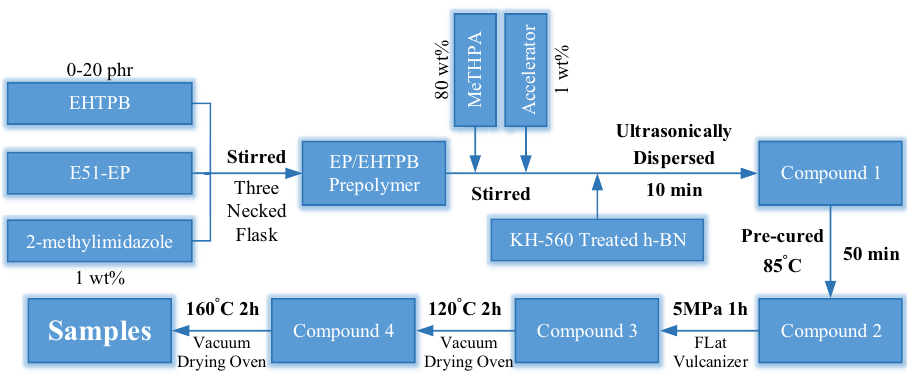
Figure 3: Procedure of EP/h - BN/EHTPB composites preparation.